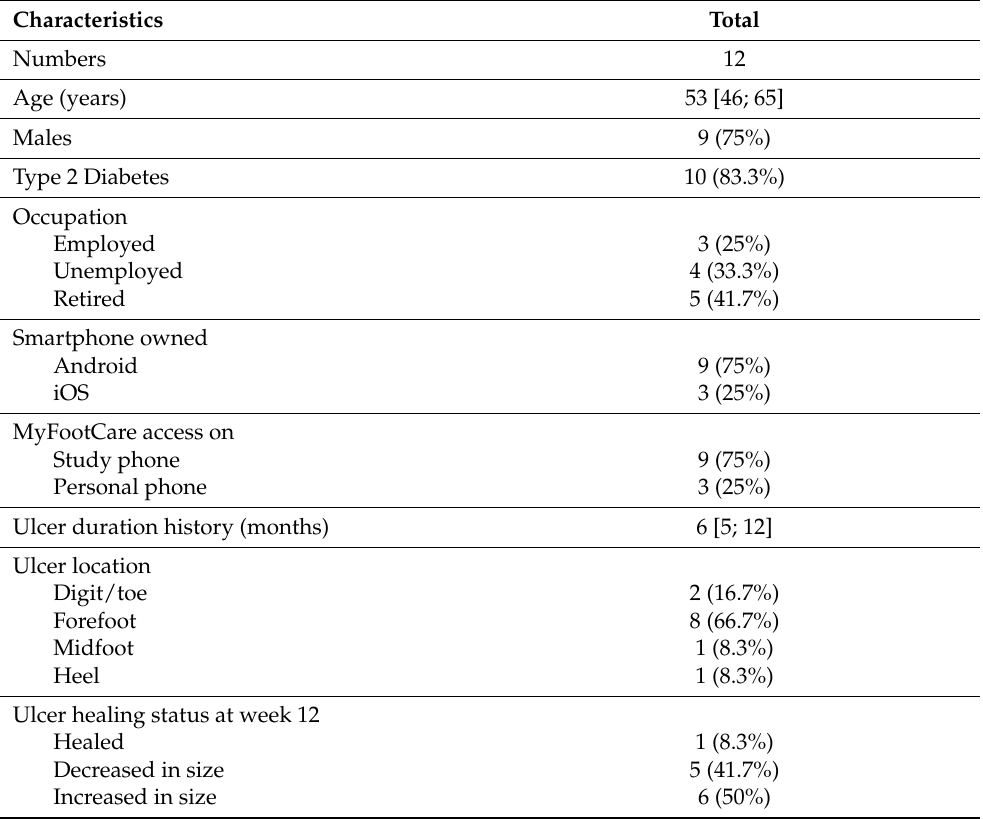
Table 1. Participant characteristics (number (%) or median (IQR), unless otherwise